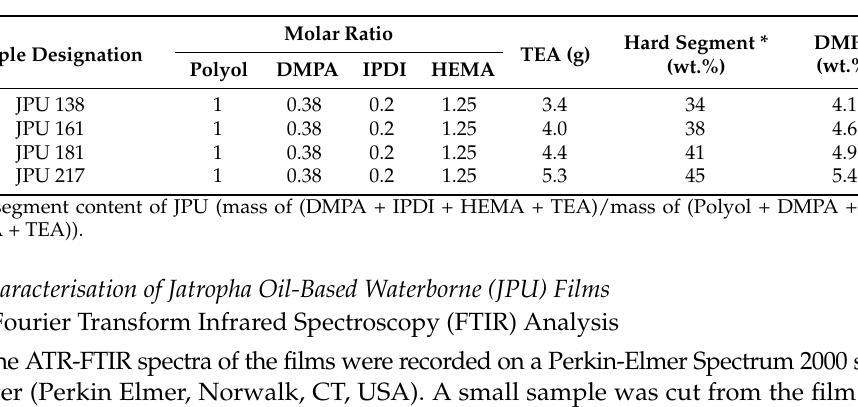
Table 1. Formulation of jatropha oil-based polyurethanes (JPU) dispersion.